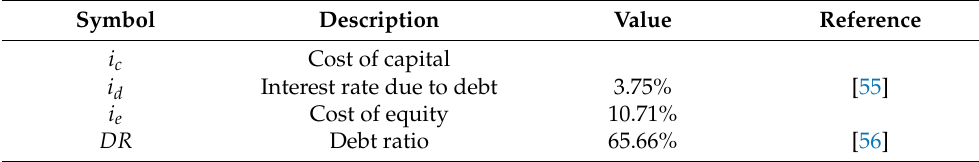
Table 7. Cost of capital definitions.